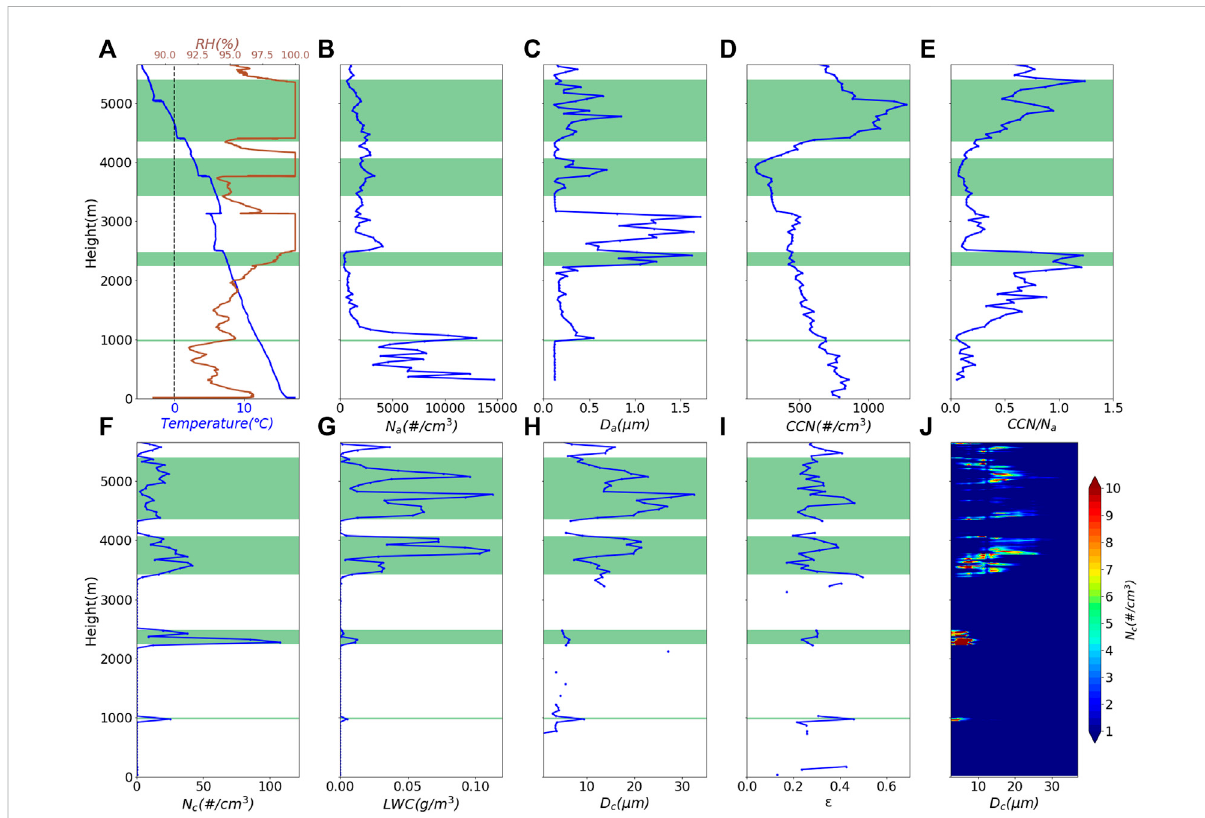
FIGURE 5 Vertical distributions of (A) temperature (blue line) and relative humidity (RH, brown line), (B) aerosol number concentration ( N a , cm – 3), (C) aerosol effective diameter ( D a , µm), (D) CCN at 0.2% supersaturation and (E) CCN/ N a ratios, (F) cloud droplet number concentration ( N c , cm − 3 ),